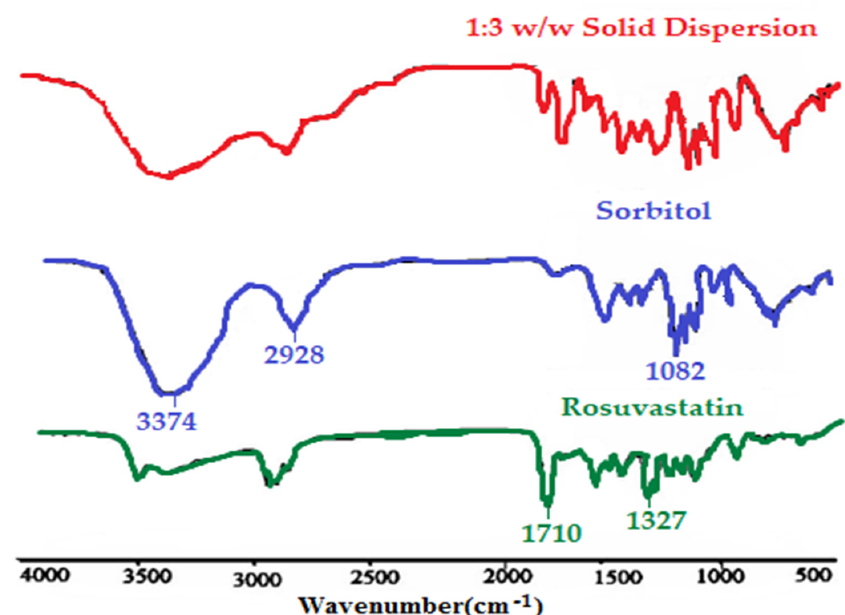
Figure 4. FT-IR spectra of pure ROS, sorbitol, and ROS-SDs (1:3).